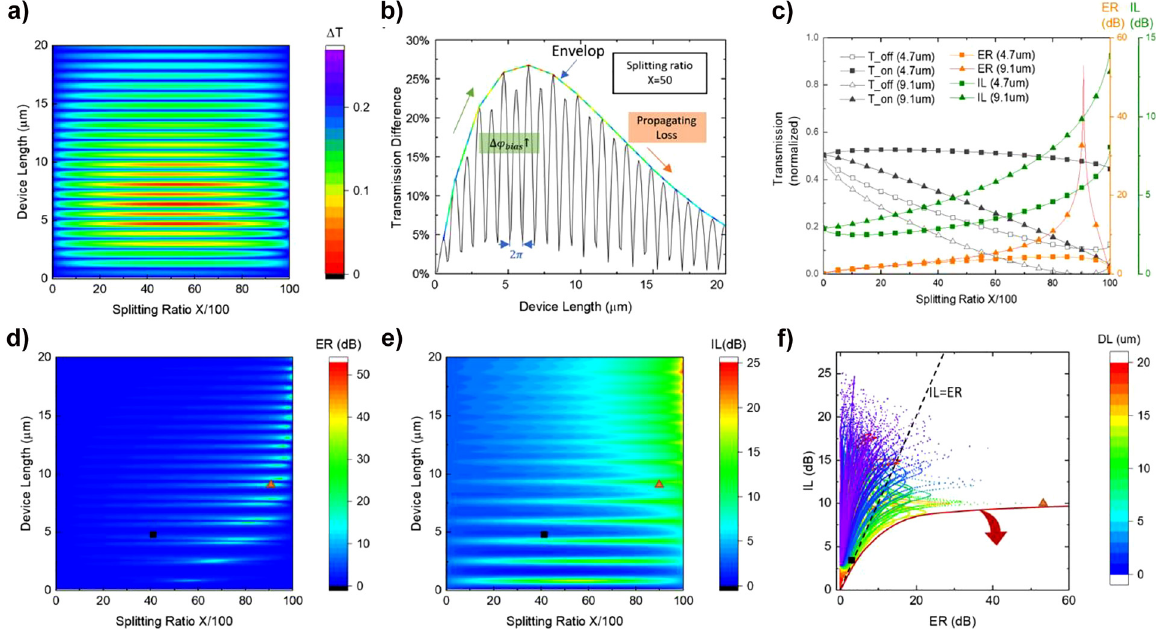
Figure 4: The performance map of asymmetric plasmonic mode ITO-based MZI modulator with 15 nm Al 2 O 3 under ON ( − 3.5 V) and OFF states ( + 3.5 V). Squares represent the device with 3 dB ER, 2.9 dB IL, 25% Δ T , and a speed of 102 GHz. Triangle represents the device with 53 dB ER, 10 dB IL, 10% Δ T , and speed of 71 GHz. (a) Transmission difference varies with splitting ratio X and device length 0 – 20 µm (more details for